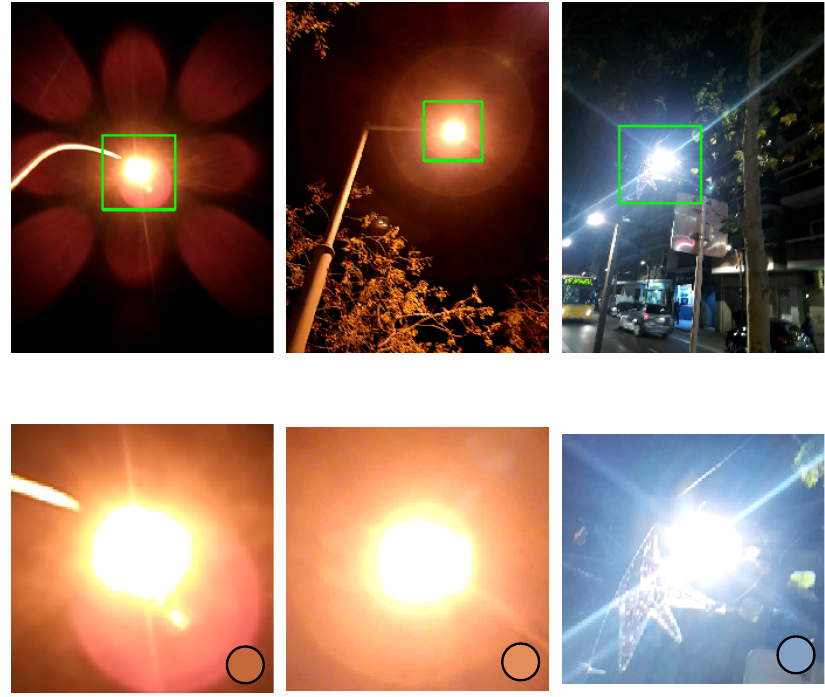
Figure 1. ( Top row ): Three examples of light source location by means of our algorithm. ( Bottom row ): The area in the rectangle of the image above is cropped and the circle in the bot- tom right corner shows the colour assigned to each lamp.